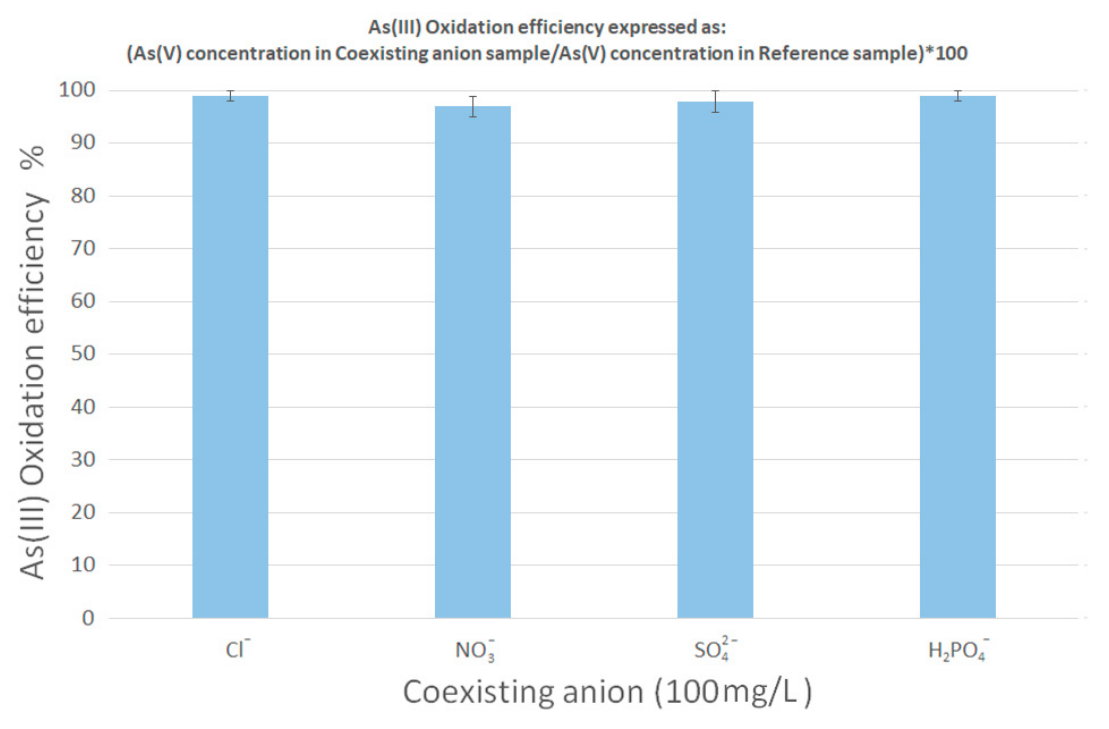
Figure 7. As(III) oxidation efficiency in presence of coexisting anions.